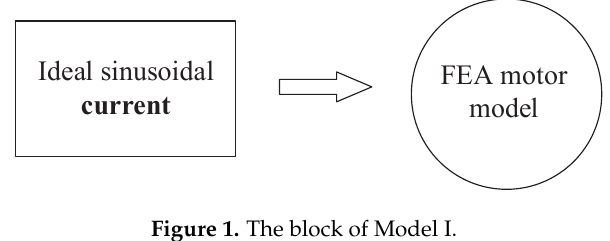
Figure 1. The block of Model I.